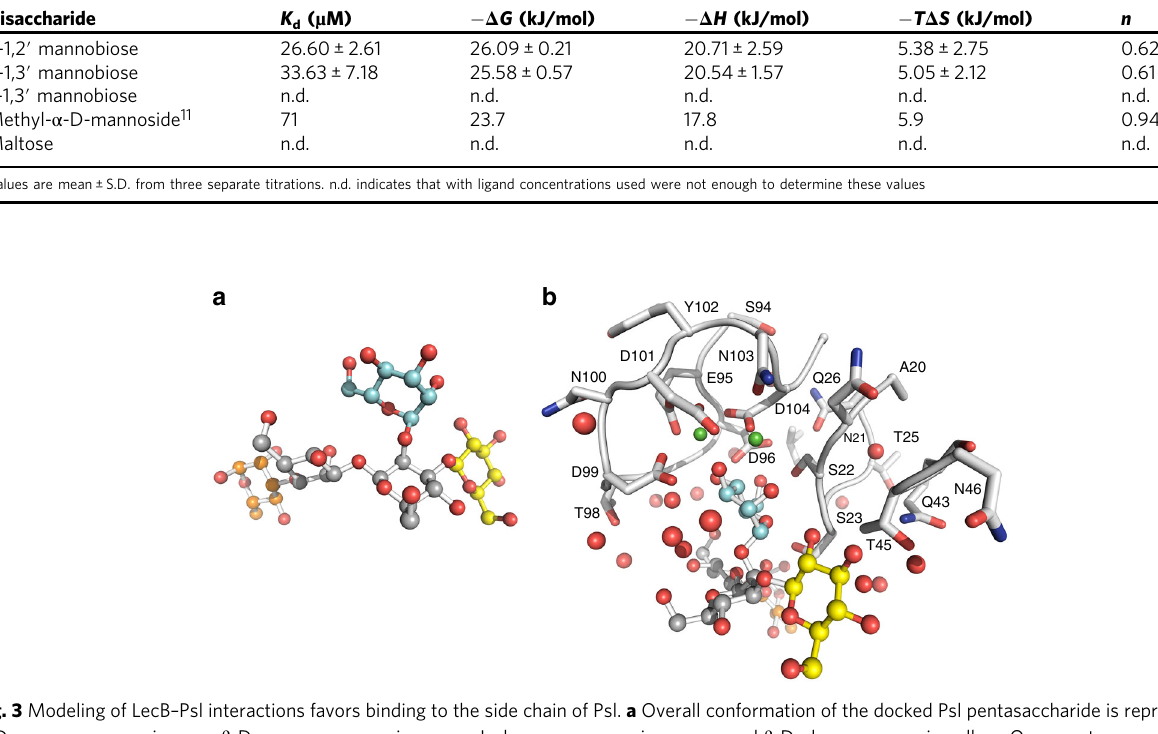
Table 1 ITC analysis for binding of LecB to different disaccharide Disaccharide